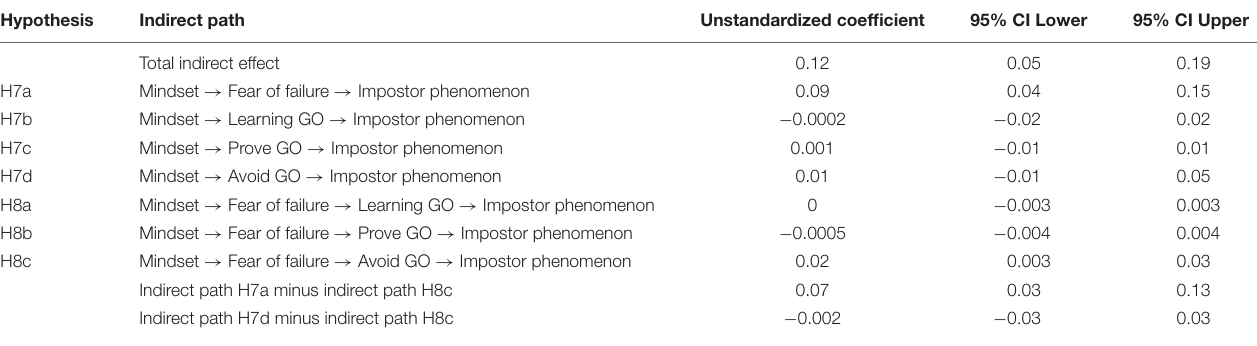
TABLE 4 | Decomposing the indirect effect of Mindset on Impostor Phenomena in the serial-parallel mediation model (5000 bootstrapped).